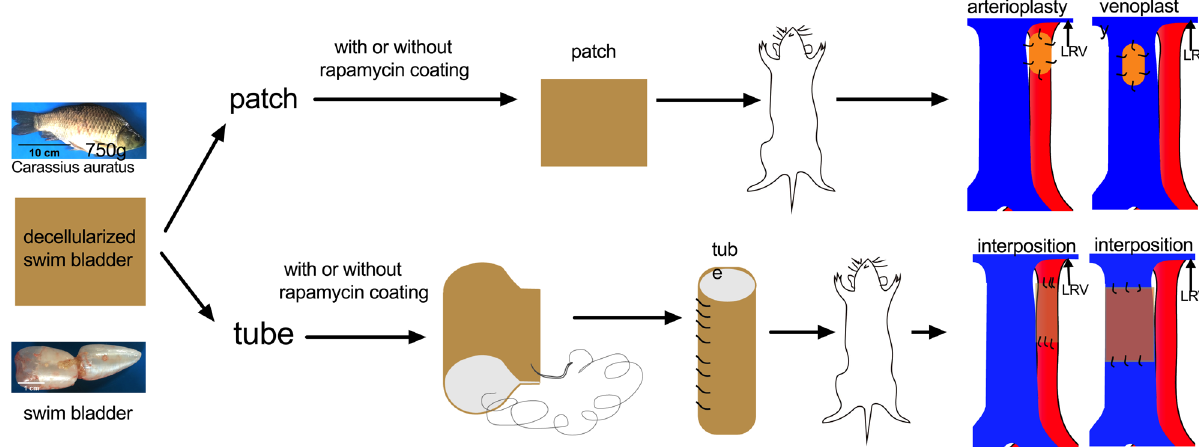
Fig. 1 Illustration showing the overall experimental design. LRV, left renal vein. This illustration was created by Dr. Hualong